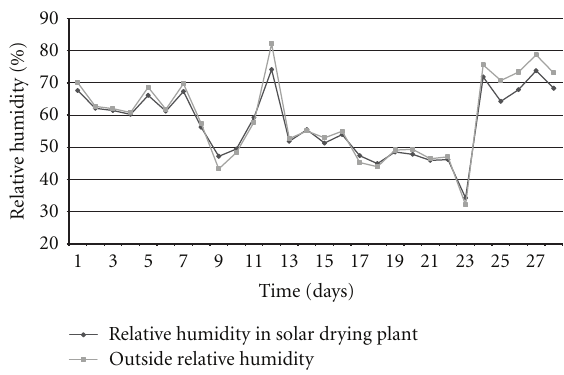
Figure 6: The course of relative humidity during the summer cycle (July).